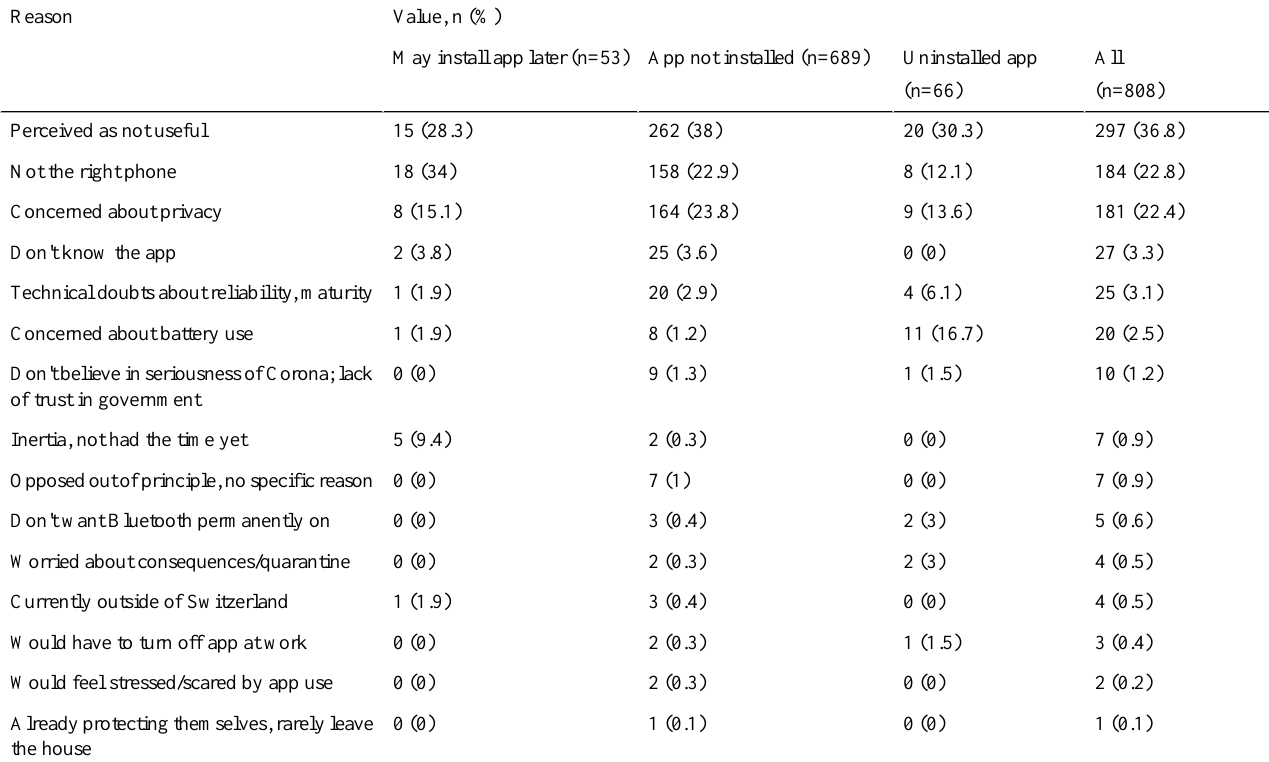
Table 3. Reasons for nonuse of the SwissCovid app.